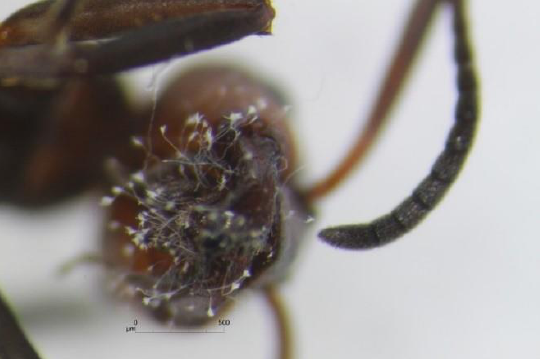
Figure 5. Conidiophores of Penicillium growing from the head of a dead F. polyctena ant. ANOVA results suggest that the forest type is a better predictor of the presence